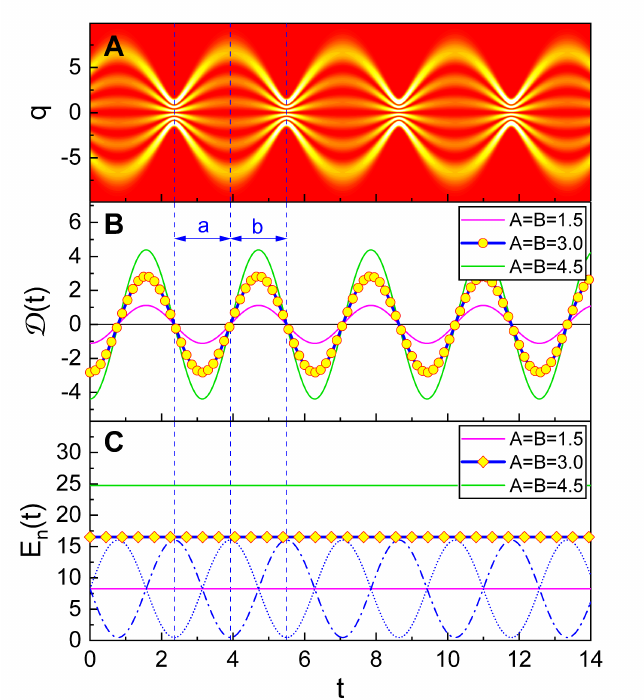
Figure 4. Contour plot of the probability density |(cid:104) q | ψ n (cid:105) GS | 2 ( A ) as a function of q and t for the quantum wave given in Equation (32), where we have chosen A = B = 3.0; the corresponding temporal evolutions of the ratio D ( t ) ( B ) and the quantum energy E n ( t ) ( C ) for several different values of A and B . a and b in ( B ) are examples of time intervals of wave expansion and collapse, respectively. The extra curves in ( C ), i.e., the dash-dot curve and the dotted curve are quantum electric energy T n ( t ) and the magnetic energy V n ( t ) , respectively, for the case of A = B = 3.0. Whereas the taken values of A and B are designated in the legends, C is taken to be C = this convention will also be used throughout the subsequent figures. We have used n = 5, ω 0 = 1, ¯ h = 1, (cid:101) = 1, t 0 = 0, and ϕ 0 = 0. We see from this figure that successive changes of the sign of D ( t ) induce periodical wave collapse and